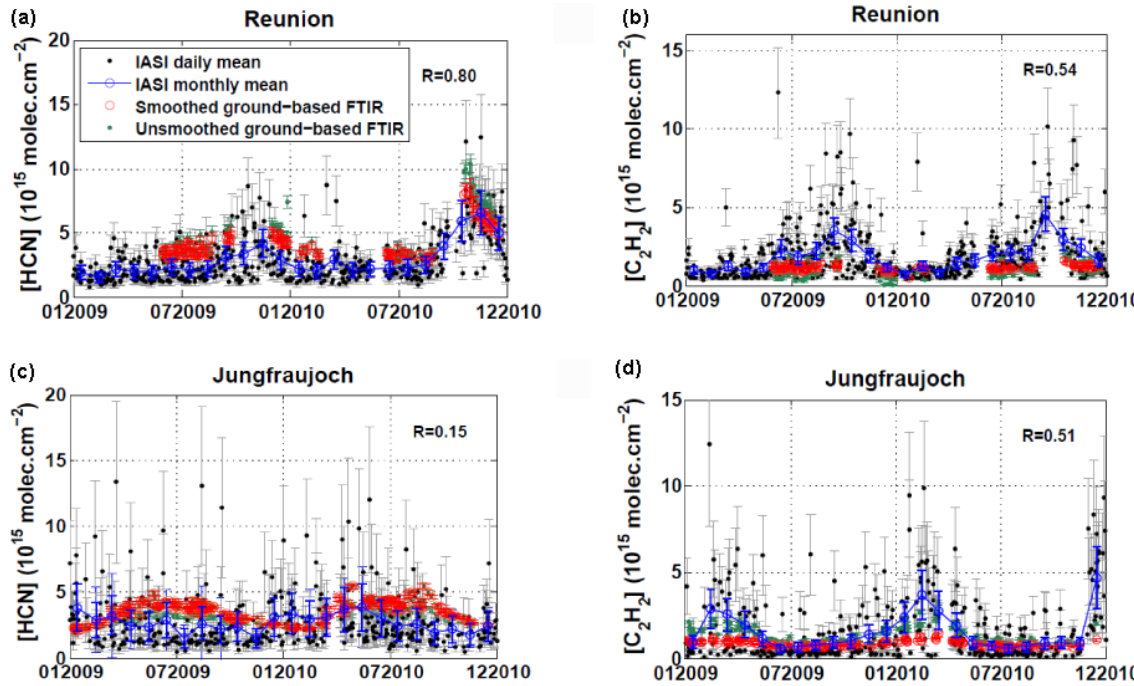
Fig. 4. Time series of HCN and C 2 H 2 measurements for Reunion Island ( a and b ) and Jungfraujoch ( c and d ). IASI measurements are shown as daily and 1 ◦ × 1 ◦ means (black dots) with associated total retrieval error (gray lines), and as monthly and 1 ◦ × 1 ◦ means (blue circles and line) with associated total retrieval error (vertical blue lines). Ground-based FTIR measurements smoothed (unsmoothed) with respect to IASI averaging kernels are shown as daily means with associated total error by red circles and line (green dots and line). Correlation coefficients of daily means are given on each plot: (a) R = 0 . 80 (101 points), (b) R = 0 . 54 (101 points), (c) R = 0 . 15 (174 points), (d) R = 0 . 51 (174